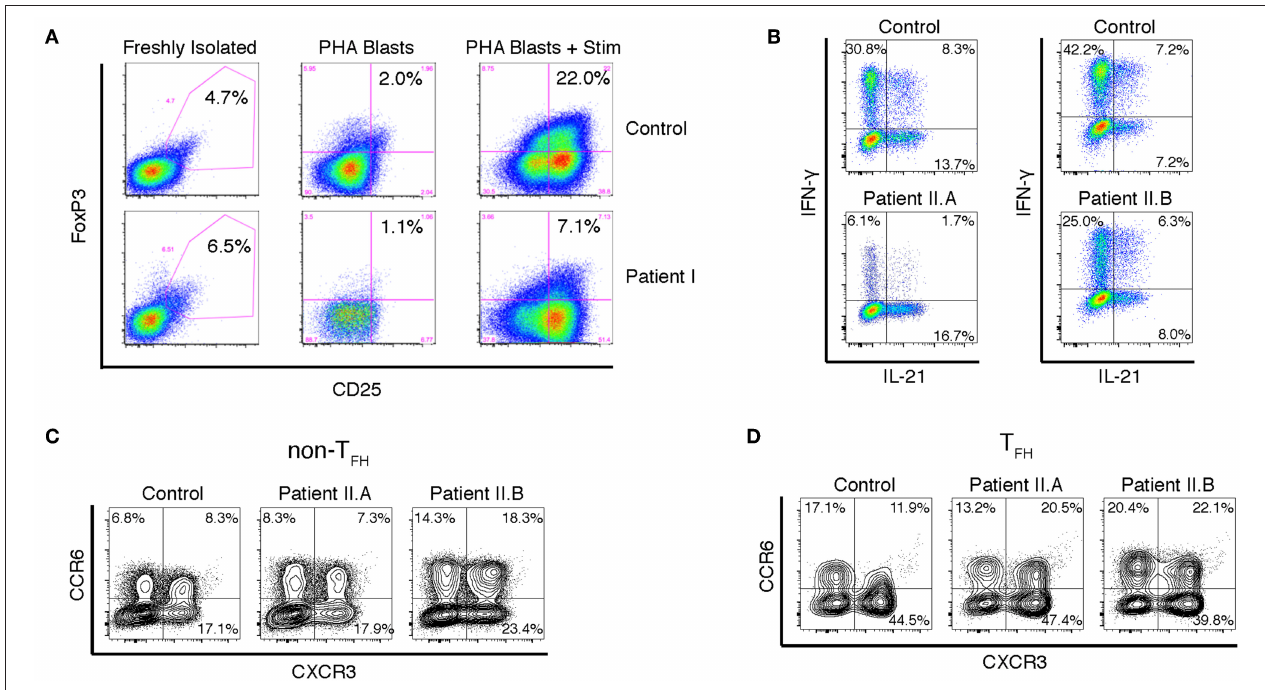
FIGURE 3 | Altered FOXP3 expression and cytokine production in T cells from APDS patients. (A) FACS analysis of CD25 + FOXP3 + Treg cells in freshly isolated PBMCs and in PHA blasts with or without restimulation with anti-CD3/28 beads and IL-2. Results are representative of three experiments. (B) Intracellular staining of CD4 + T cell blasts stimulated with PMA and ionomycin. (C,D) FACS analysis of chemokine receptors on CD4 + cells from freshly isolated PBMCs. CXCR5- non-Tfh cells (C) and CXCR5 + PD-1 + Tfh cells (D) were assayed for CXCR3 and CCR6